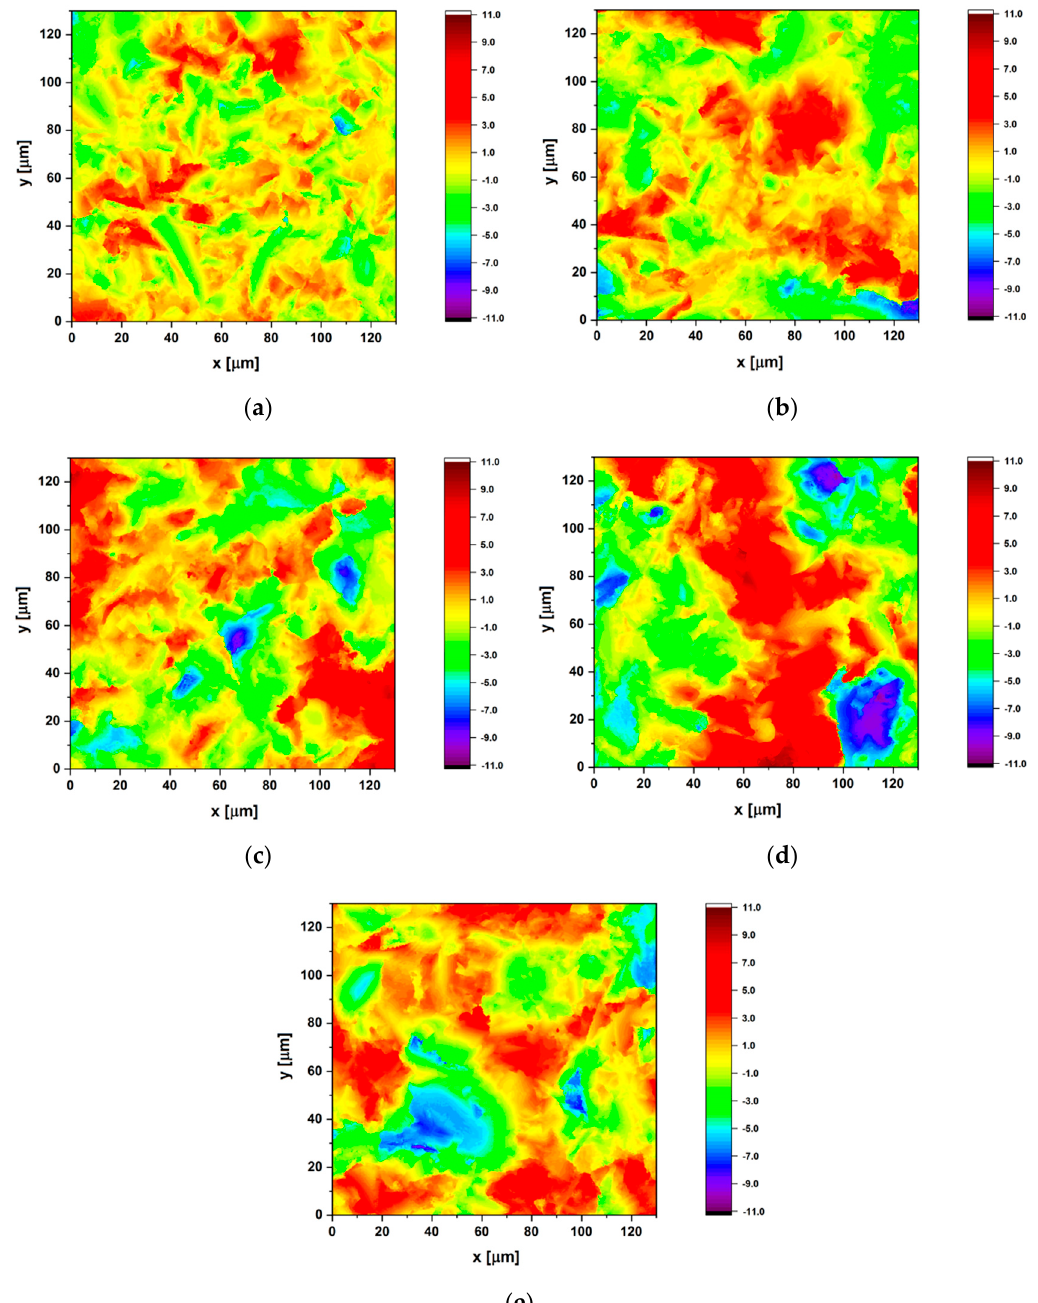
Figure 6. Surface topography map (130 × 130 µ m 2 ) obtained for the Ti G4 subjected to: ( a ) Sandblasting; ( b ) Sandblasting and autoclaving for 30 min; ( c ) Sandblasting and autoclaving for 60 min; ( d ) Sandblasting and autoclaving for 90 min; ( e ) Sandblasting and autoclaving for 120 min. Table 7. Sa parameter defined as arithmetical mean height of the scale limited surface evaluated over the complete 3D surface in accordance with ISO 25178–2 [63] for the Ti G4 before and after autoclaving.